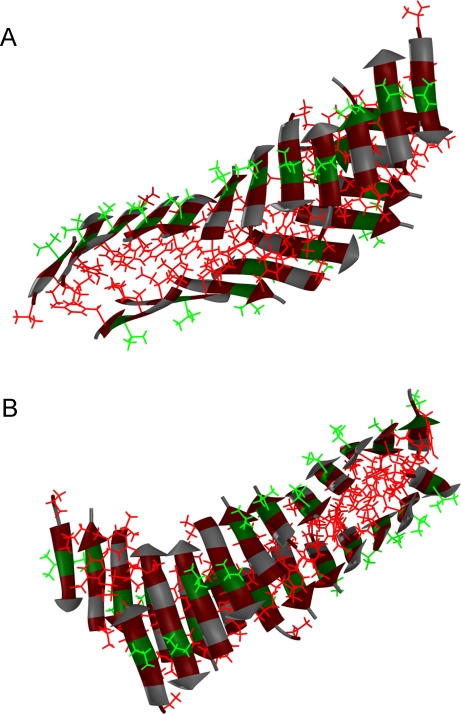
Snapshots of two large aggregates from (a) an unseeded and (b) a seeded 24-chain run.Side-chain colors are as in Figure 2.